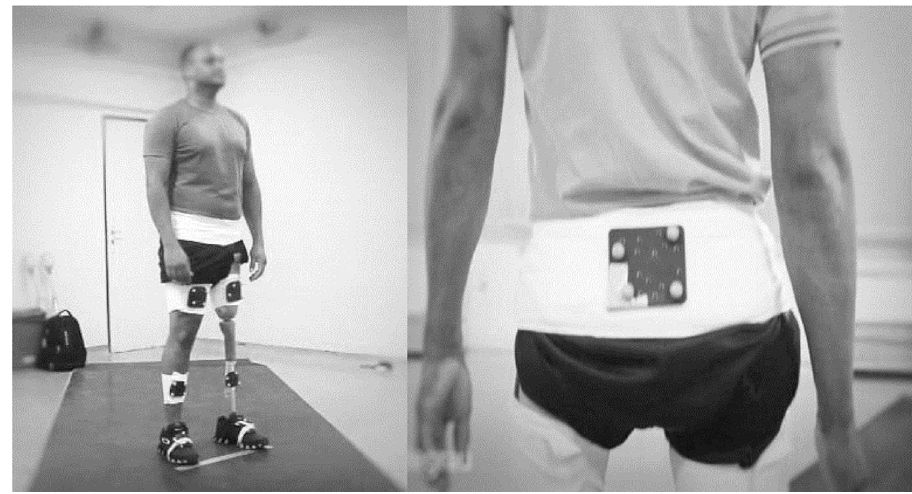
Figure 1. Positioning of clusters with retro-reflective marks fixed on the rigid plate.